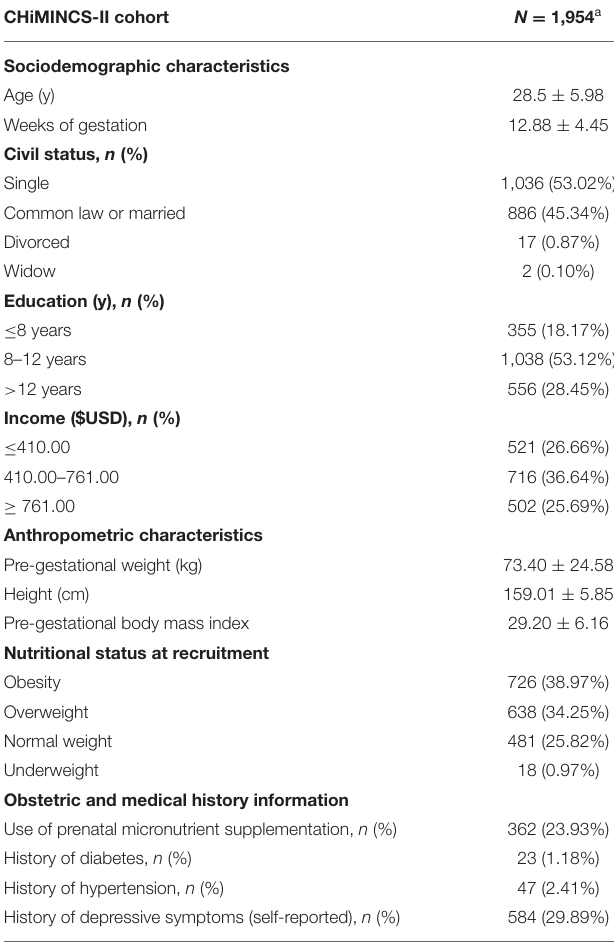
TABLE 2 | Baseline maternal characteristics of the CHiMINCs-II cohort participants (Chile,